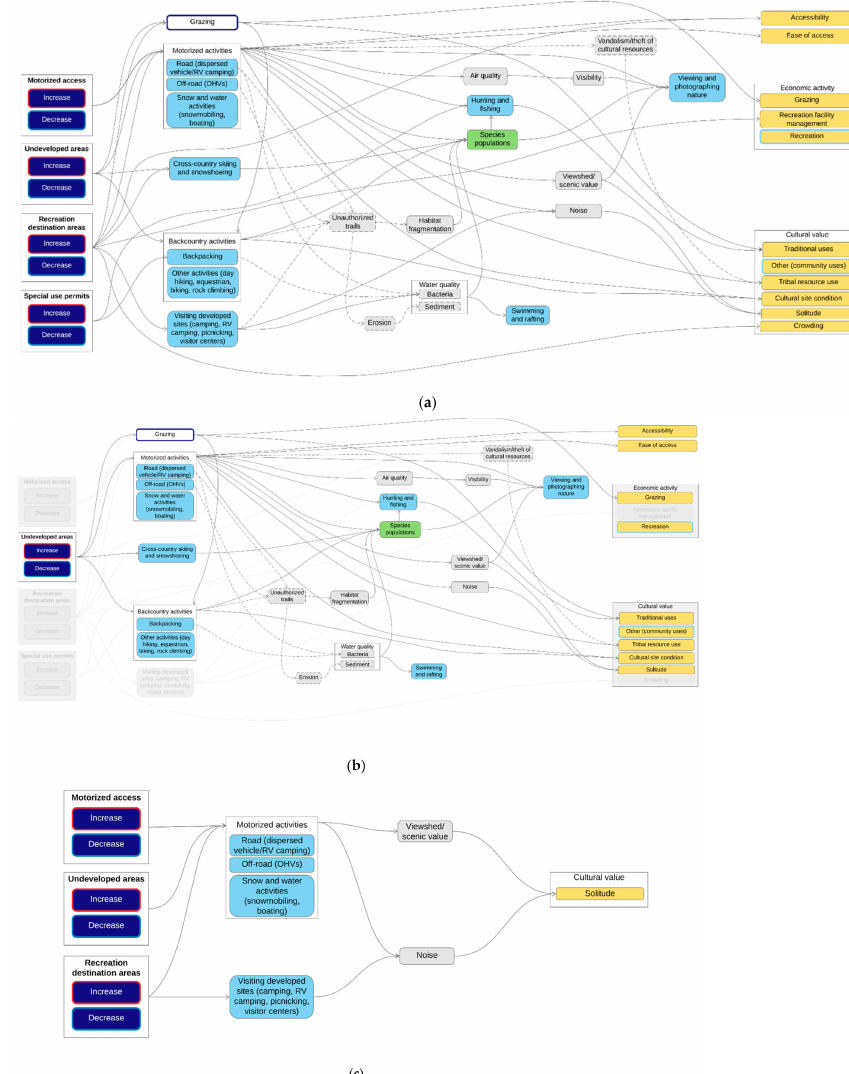
Figure 3. Simplified visualizations of the ESCMs explored for communication purposed include one ( a ) with fewer intermediate nodes, ( b ) one showing pathways and outcomes for a single management category, and ( c ) one showing what management categories and pathways lead to single